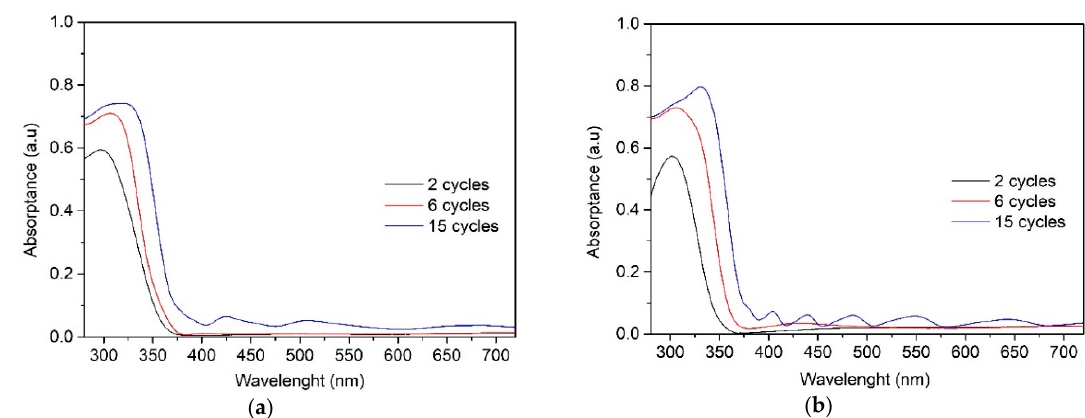
Figure 9. UV–Vis absorption spectra of the TiO 2 films deposited with solutions of ( a ) 0.1 M and ( b ) 0.2 M and varying the number of spray cycles from 2 to 15.